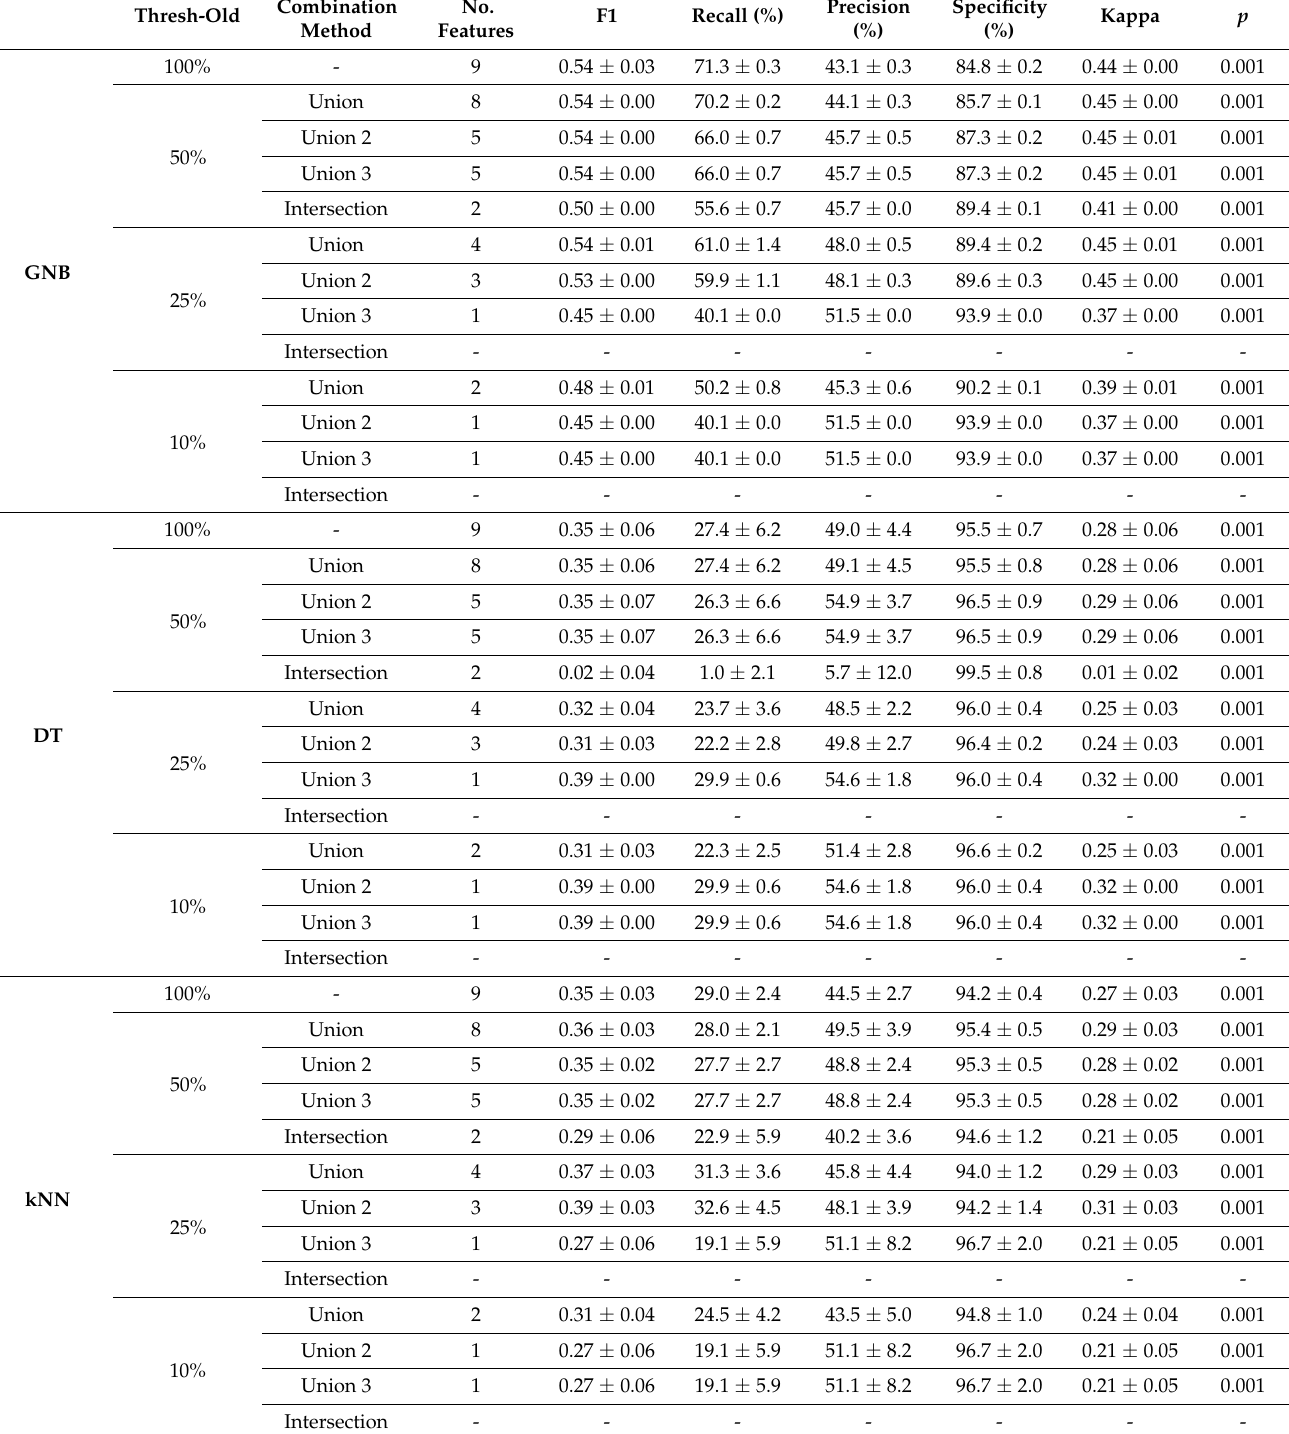
Table A12. Performance of the four classification models on detection fall using Early Mobility Impairment Questionnaire data set ; Gaussian Naive Bayes (GNB); Decision Tree (DT); k-Nearest Neighbor (kNN); Support Vector Machine (SVM); p -value via permutation